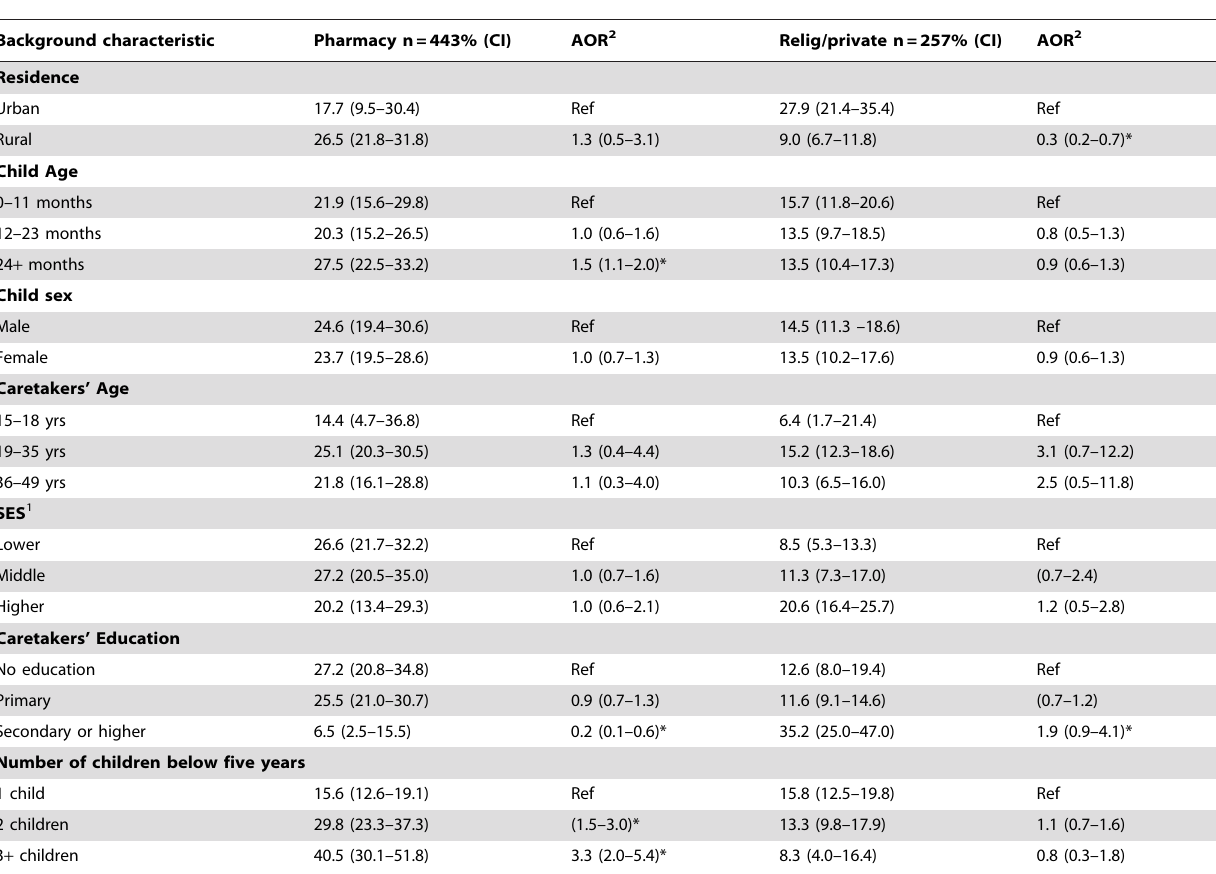
Table 5. Non-public facilities as the first option of care for fever and/or cough versus background